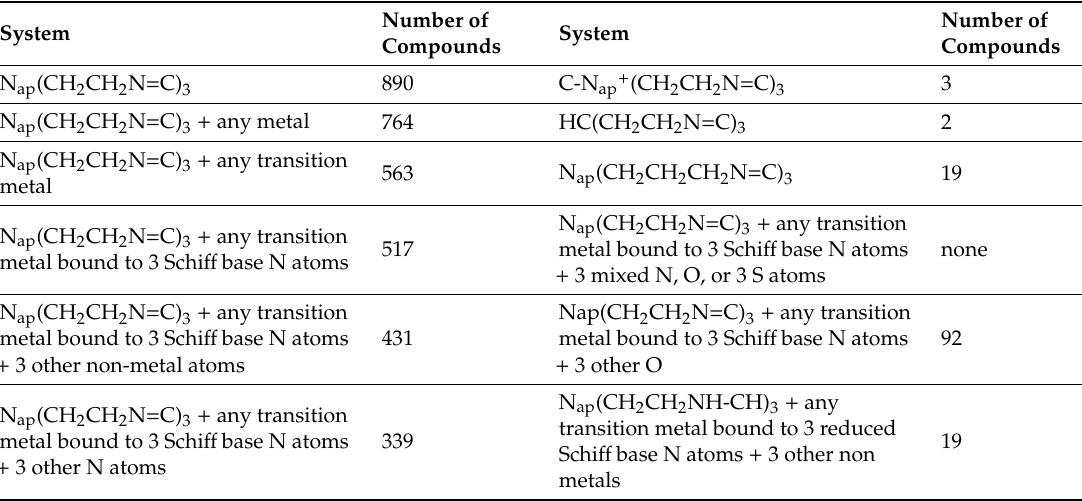
Table 1. Survey of the number of structurally characterized tren Schi ff base compounds. The central or apical nitrogen atom of the tripodal amine is labeled to as N ap